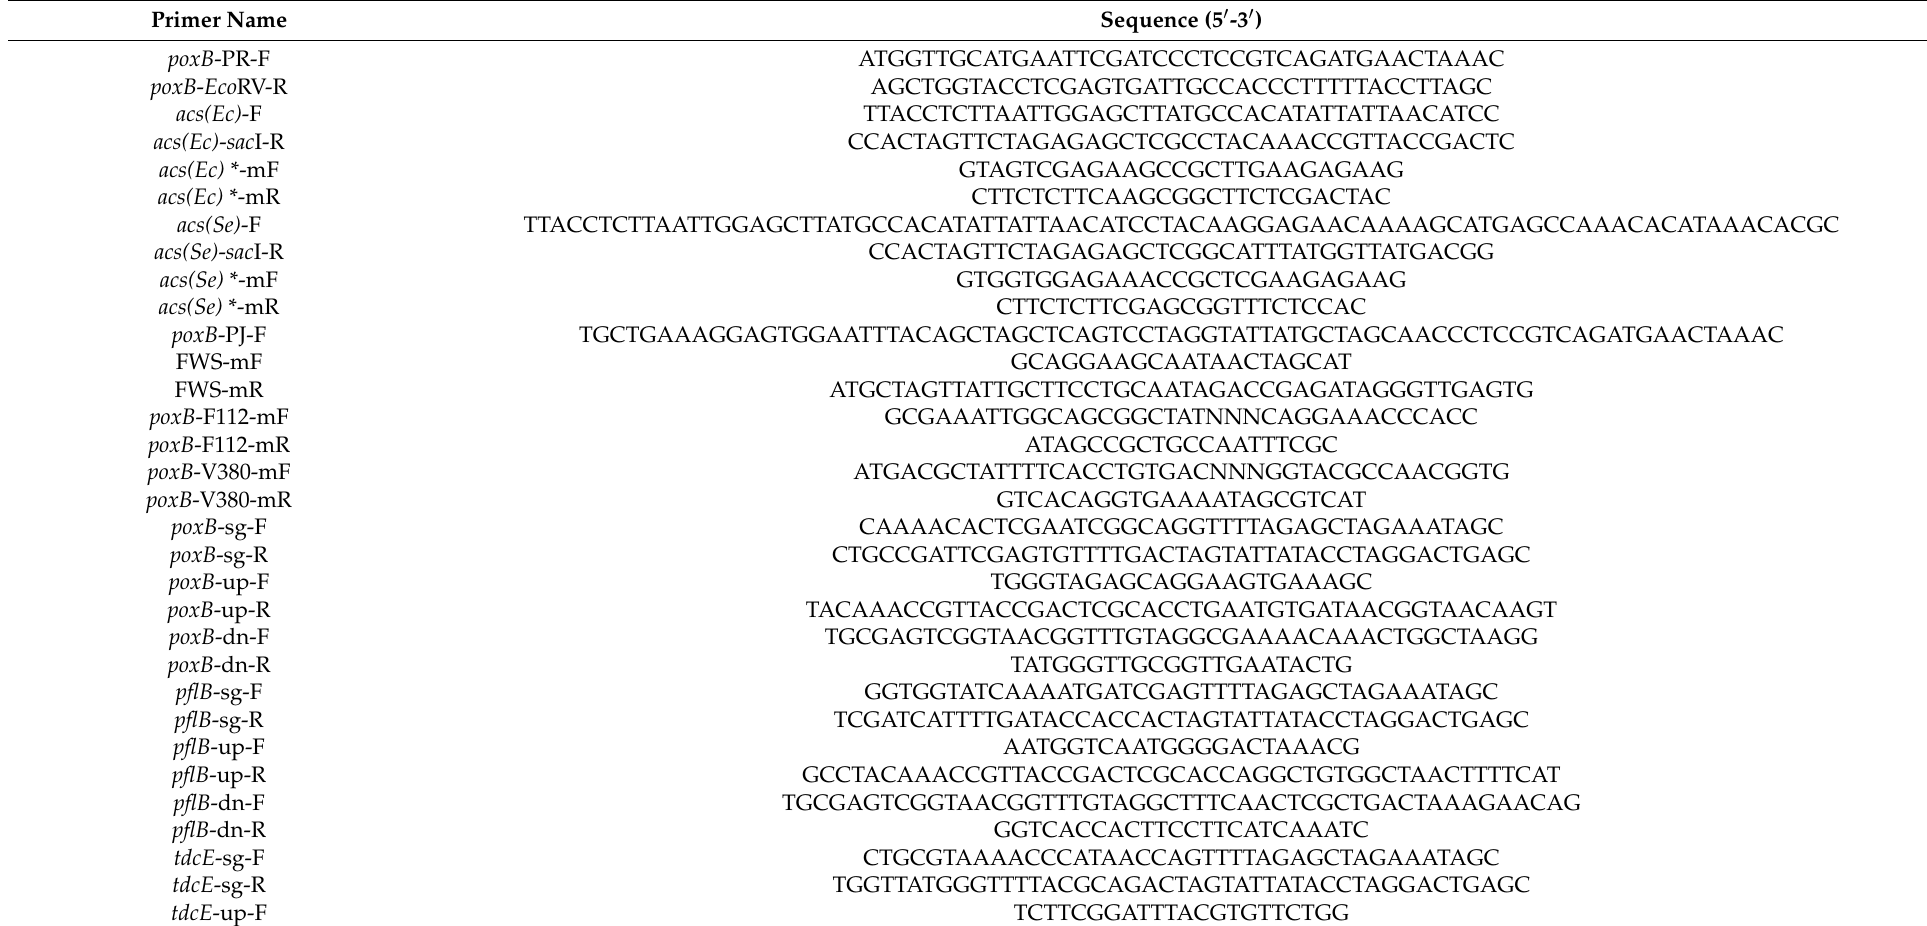
Table 3. Primers used in this